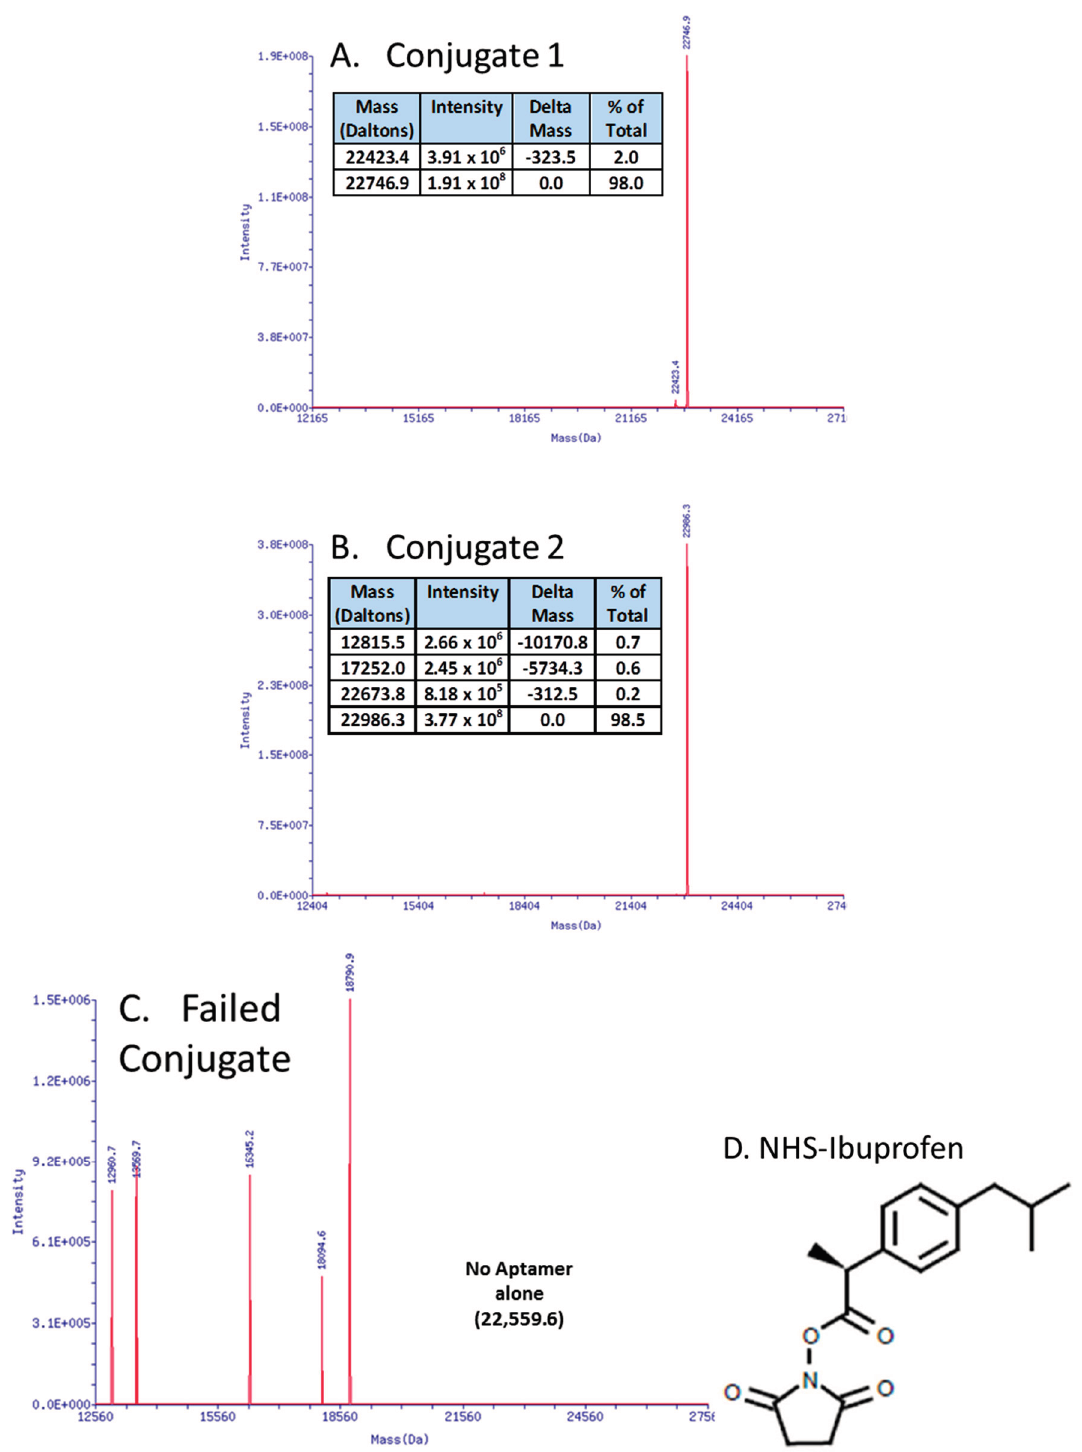
Figure 3. Mass spectral data showing successful aptamer-3'-ibuprofen conjugation ( A , B ) versus the surprisingly fragmented DNA resulting from a carbodiimide-mediated approach ( C ). The successful approach involved the use of a custom N-hydroxysuccinimide (NHS)-ibuprofen linker synthesized by Sigma-Aldrich Corp. ( D ) resulting in >98% yields of the correct conjugates (actual vs. theoretical molecular weights matched for aptamer-ibuprofen conjugates as determined by mass spectra in panels A and